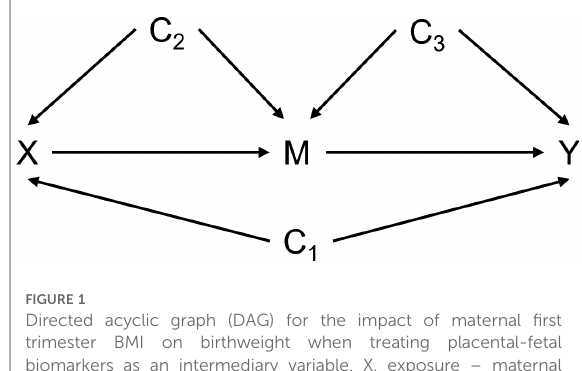
FIGURE 1 Directed acyclic graph (DAG) for the impact of maternal fi rst trimester BMI on birthweight when treating placental-fetal biomarkers as an intermediary variable. X, exposure – maternal fi rst trimester body mass index; M, mediator – maternal serum placental-fetal biomarkers; Y, outcome – birthweight z-score; C 1 , confounders of X-Y, the BMI and birthweight association; C 2 , confounders of X-M, the BMI and placental-fetal biomarker association; C 3 , confounders of M-Y, the placental-fetal biomarker and birthweight association The med4way macro does not distinguish between the C 1 , C 2 , C 3